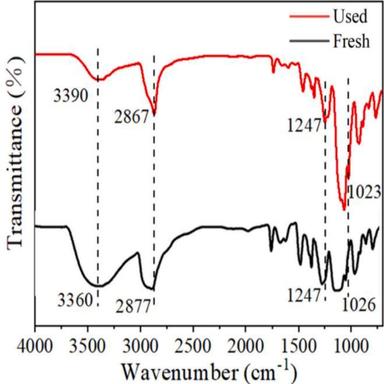
FT-IR spectrum of the CO2-responsive phase transfer materials before and after reaction.